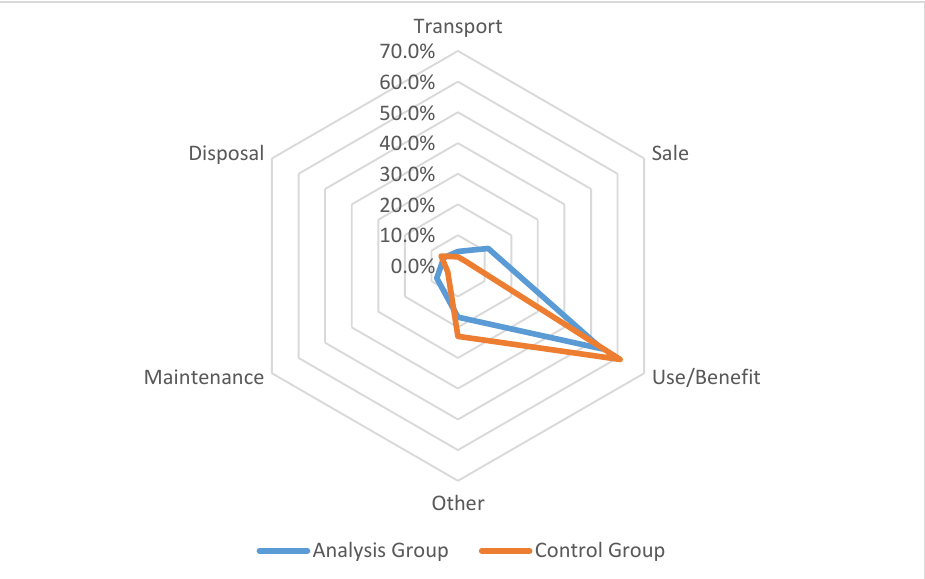
Figure 7. Radar plot of the distribution of requirements across the life cycle phases listed in Table 4.